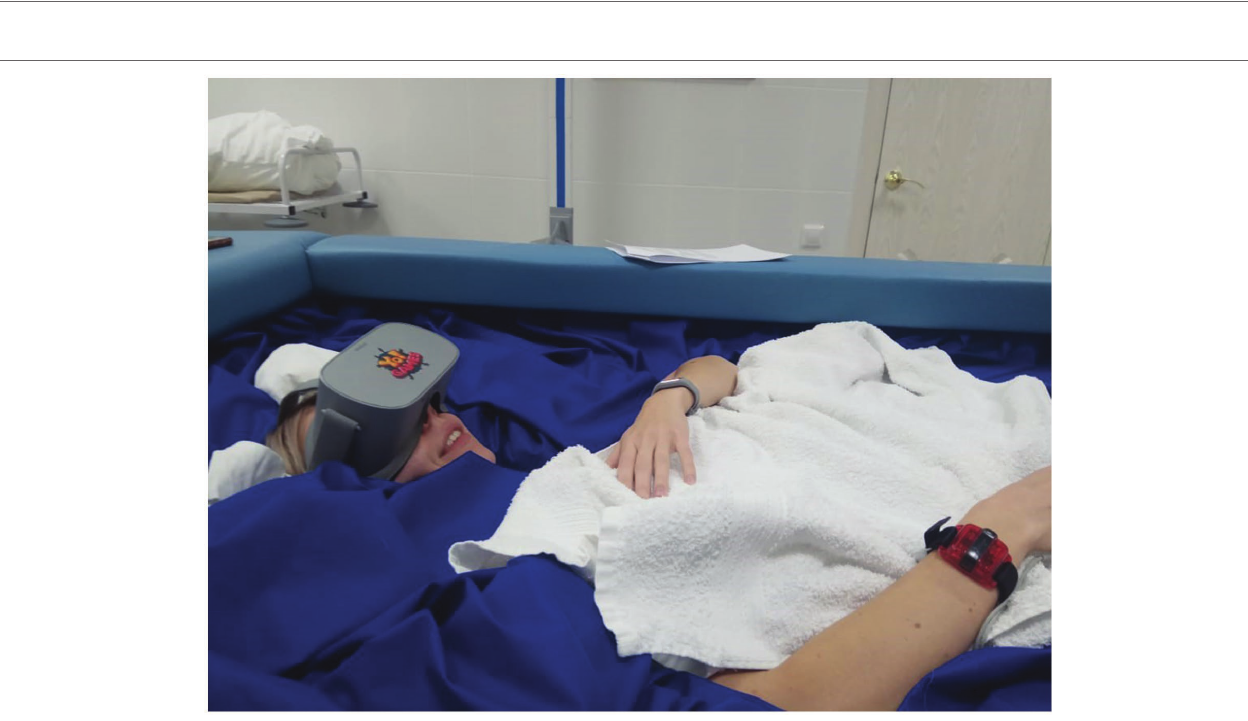
FIGURE 2 | Using a VR as a psychological support tool during «dry» immersion. Copyright by Ivan A. Rozanov, October